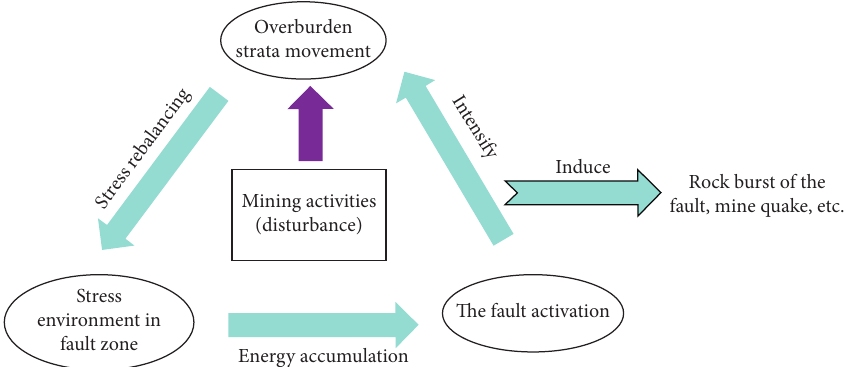
Figure 16: Relationship among overburden movement, the stress evolution of fault zone, and induced dynamic disasters.